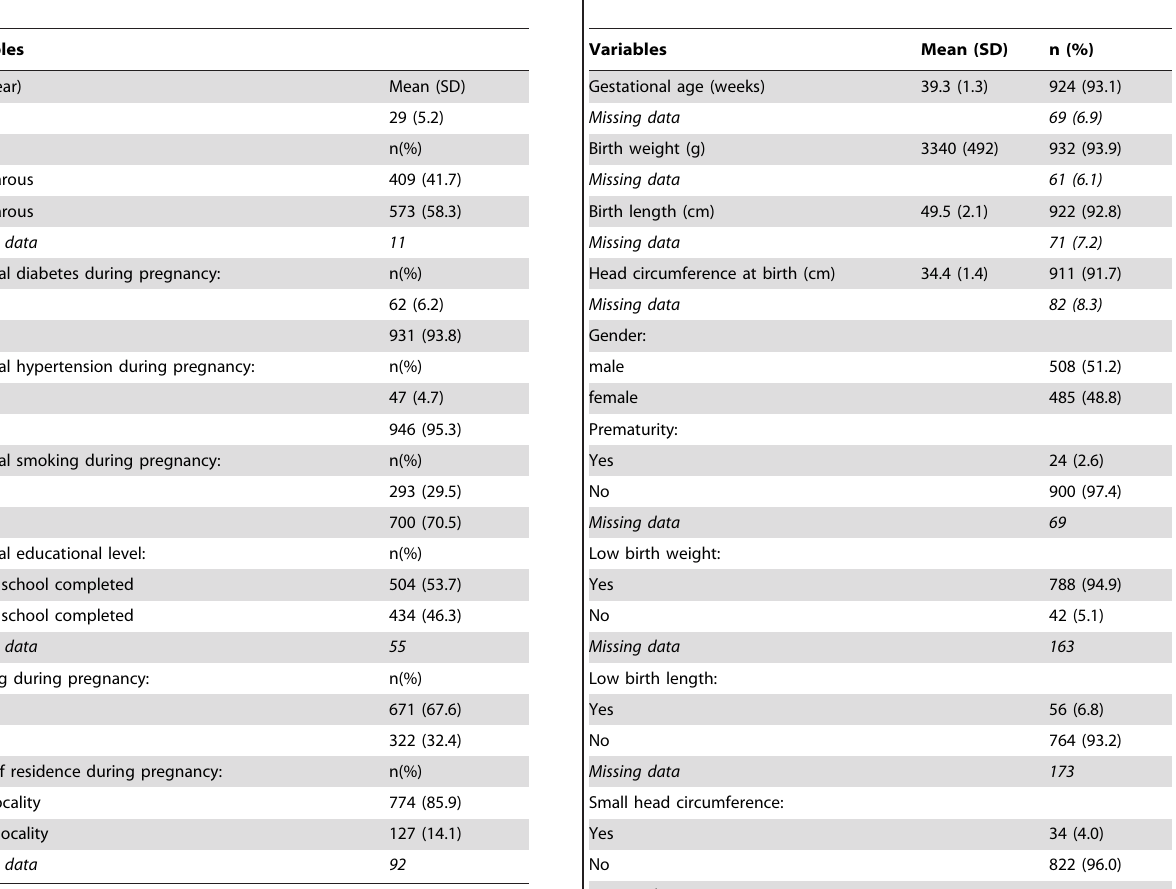
Table 1. Maternal characteristics in the MecoExpo cohort (n=993).